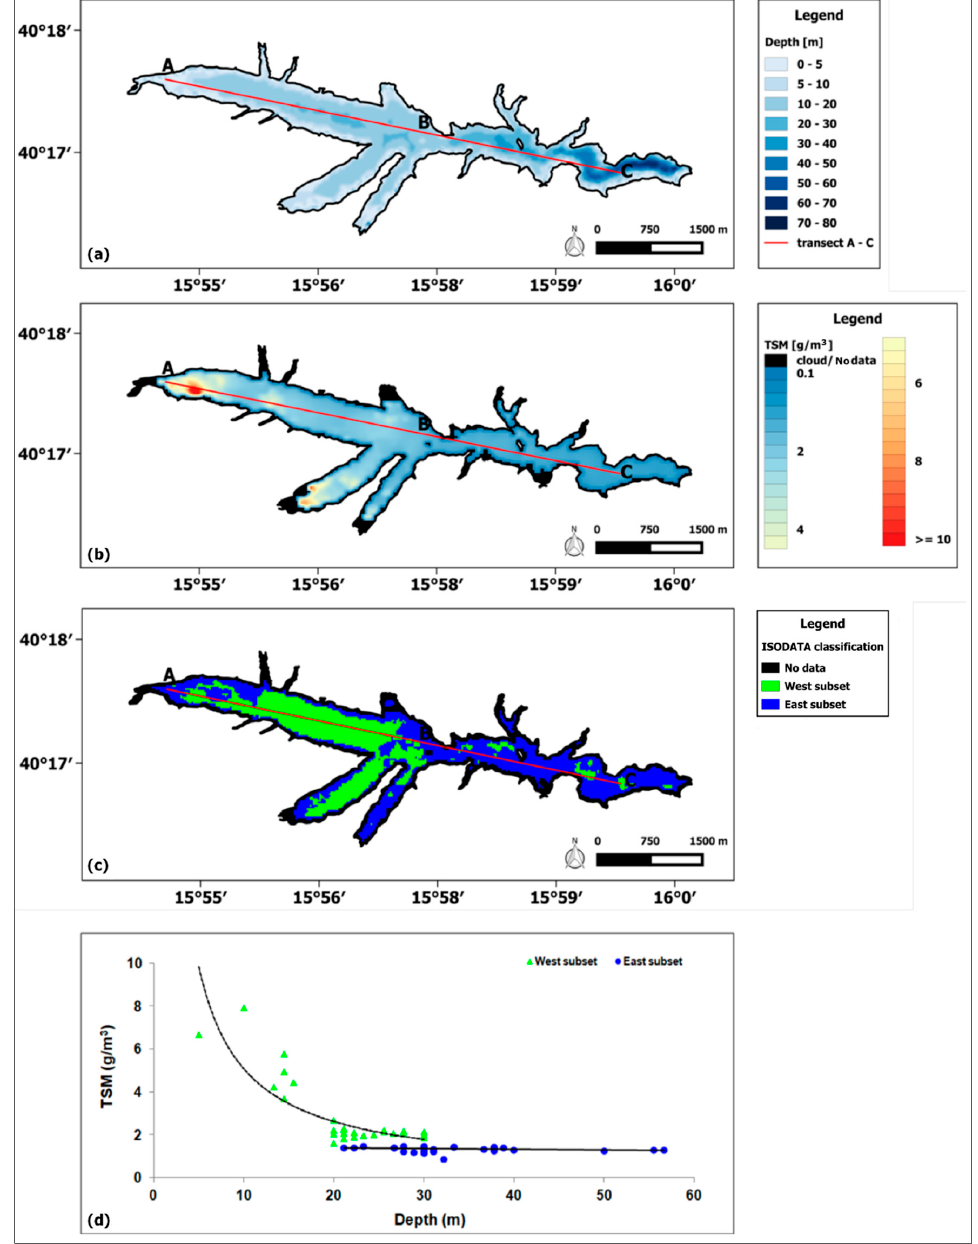
Figure 12. ( a ) September 2007 bathymetry map adapted from CRA-ABP. The continuous red line is the A–C transect; ( b ) September interannual (2014–2018) averaged TSM map; ( c ) ISODATA unsupervised classification map; ( d ) Scatterplot of TSM and depth values along the A–C transect. The green triangles and the blue dots indicate the TSM–depth variations within the West and East subsets, respectively. The dashed and continuous lines are the best fit functions estimated for West and East areas, respectively.